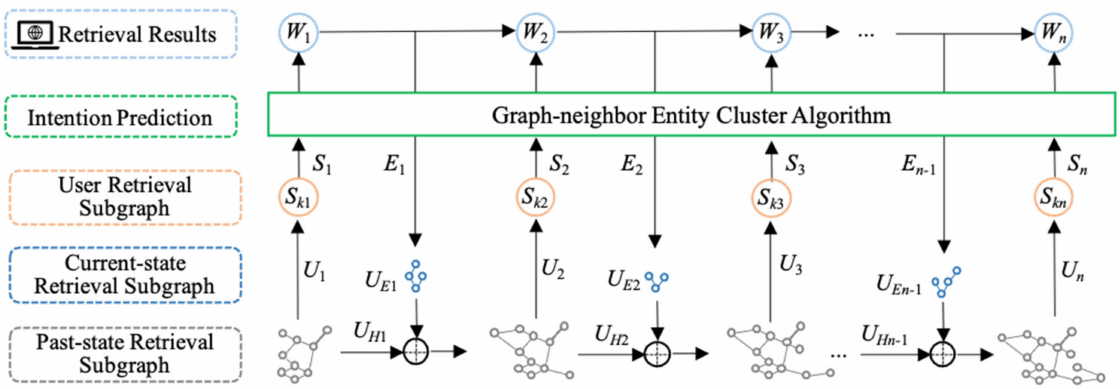
Figure 5. User-polymorphic recommendation